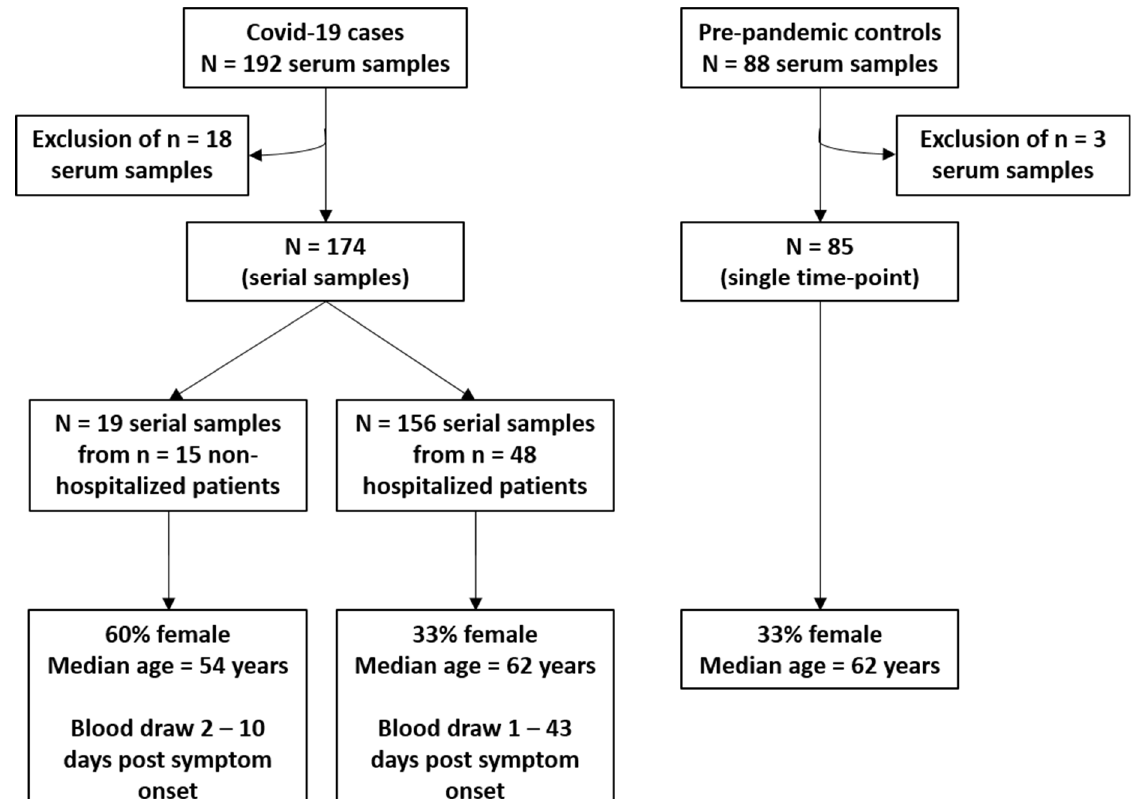
Figure 1. Schematic study diagram. COVID-19 cases were recruited at Heidelberg University Clinics between March and May 2020. Of the n = 192 serum samples, n = 18 samples were excluded due to technical errors, a negative SARS-CoV-2 PCR test, or missing information about onset of symptoms. Pre-pandemic controls were obtained from the ESTHER I study (“Epidemiologische Studie zu Chancen der Verhütung, Früherkennung und optimierten Therapie chronischer Erkrankungen in der älteren Bevölkerung”), a prospective cohort that enrolled subjects aged 50–75 years between 2000 and 2002 in Saarland, Germany. We randomly selected n = 88 participants to frequency match the age- and sex-distribution among the hospitalized n = 48 COVID-19 patients. Due to technical errors, n = 3 serum samples were excluded.